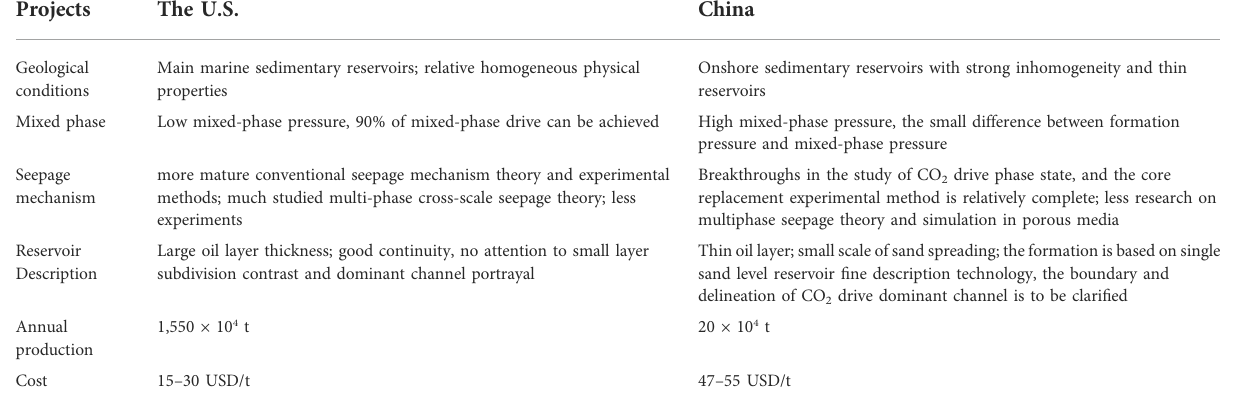
TABLE 1 Comparison of Chinese and US CO 2 oil drive technologies (Xiang et al). Projects The